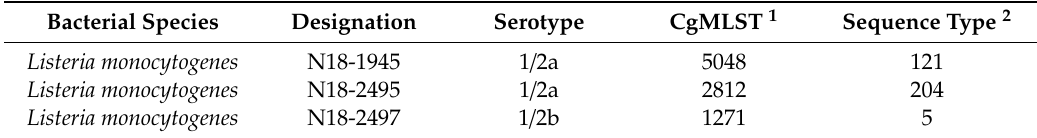
Table 1. L. monocytogenes strains used in this